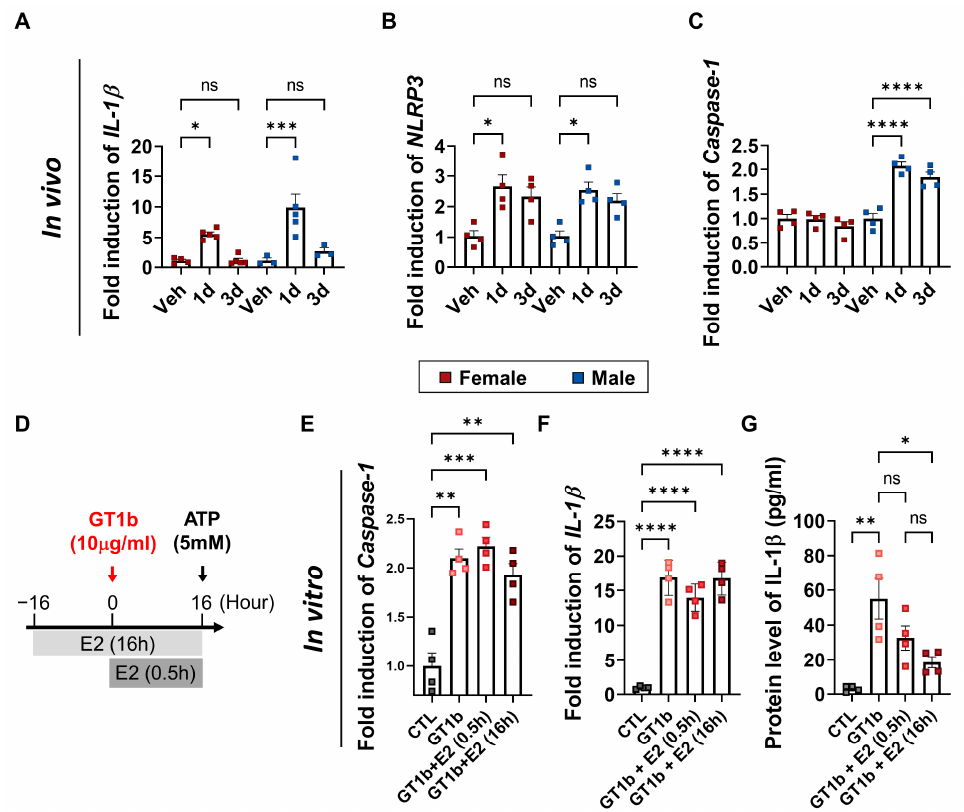
Figure 4. 17 β -estradiol regulates post-translational IL-1 β modification. Transcript levels of ( A ) IL-1 β , ( B ) NLRP3, and ( C ) Caspase-1 in the spinal cord after GT1b i.t. injection (n = from 3 to 5/group, two-way ANOVA with post hoc Tukey’s multiple comparison test). ( D ) Experimental scheme of the IL-1 β release assay from primary glia. ( E) Transcript levels of Caspase-1, ( F ) IL-1 β , and ( G ) protein levels of released IL-1 β from primary glia (n = 4/group, one-way ANOVA with post hoc Tukey’s multiple comparison test). Data are presented as mean ± SEM. ns: not significant, * P < 0.05, ** P < 0.01, *** P < 0.001, and **** P <